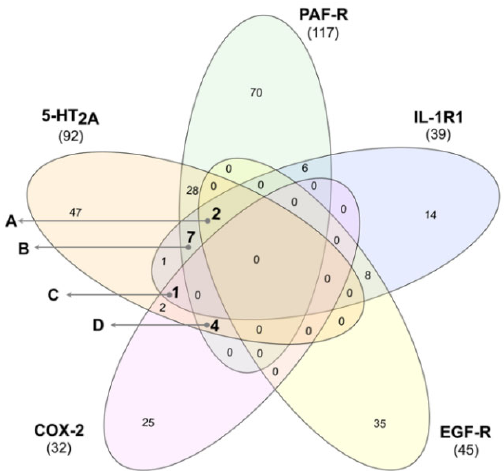
Figure 6. Multi-target representative compounds identified in the virtual screening. The compounds showing the best binding scores for each target were selected. The common compounds among the targets were identified using a five ‐ way Venn diagram. The number of compounds selected for each group are in parentheses after oval shape headings. Common metabolites for at least three targets were defined as multi ‐ target compounds. We found 14 multi ‐ target representative compounds based on the intersects: (A) 5 ‐ HT 2A , PAF ‐ R, IL ‐ 1R1, and EGF ‐ R; (B) 5 ‐ HT 2A , PAF ‐ R, and IL ‐ 1R1; (C) 5 ‐ HT 2A , IL ‐ 1R1, and COX ‐ 2; (D) 5 ‐ HT 2A , PAF ‐ R, and COX ‐ 2.